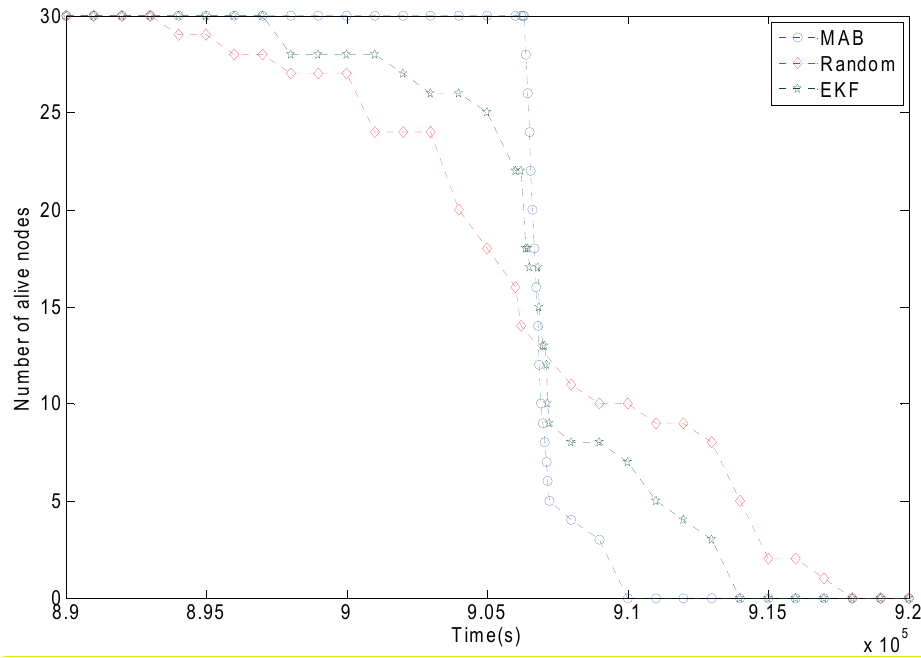
Figure 19. The comparison of the network lifetime between different packet-sizing